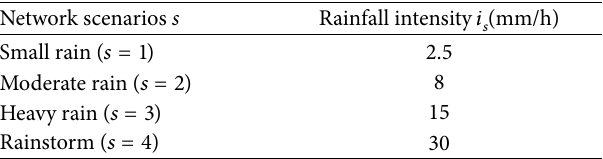
Table 5: Rainfall network scenarios and corresponding intensities.